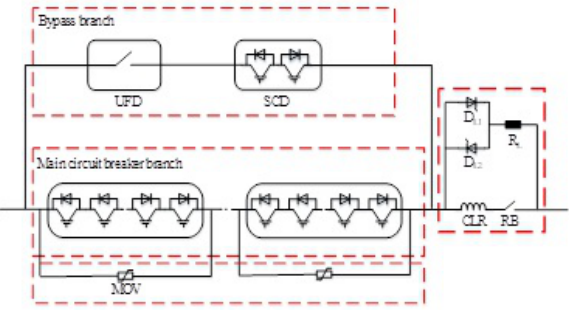
Fig. 2. Structure diagram of current-limiting hybrid DC circuit breaker.